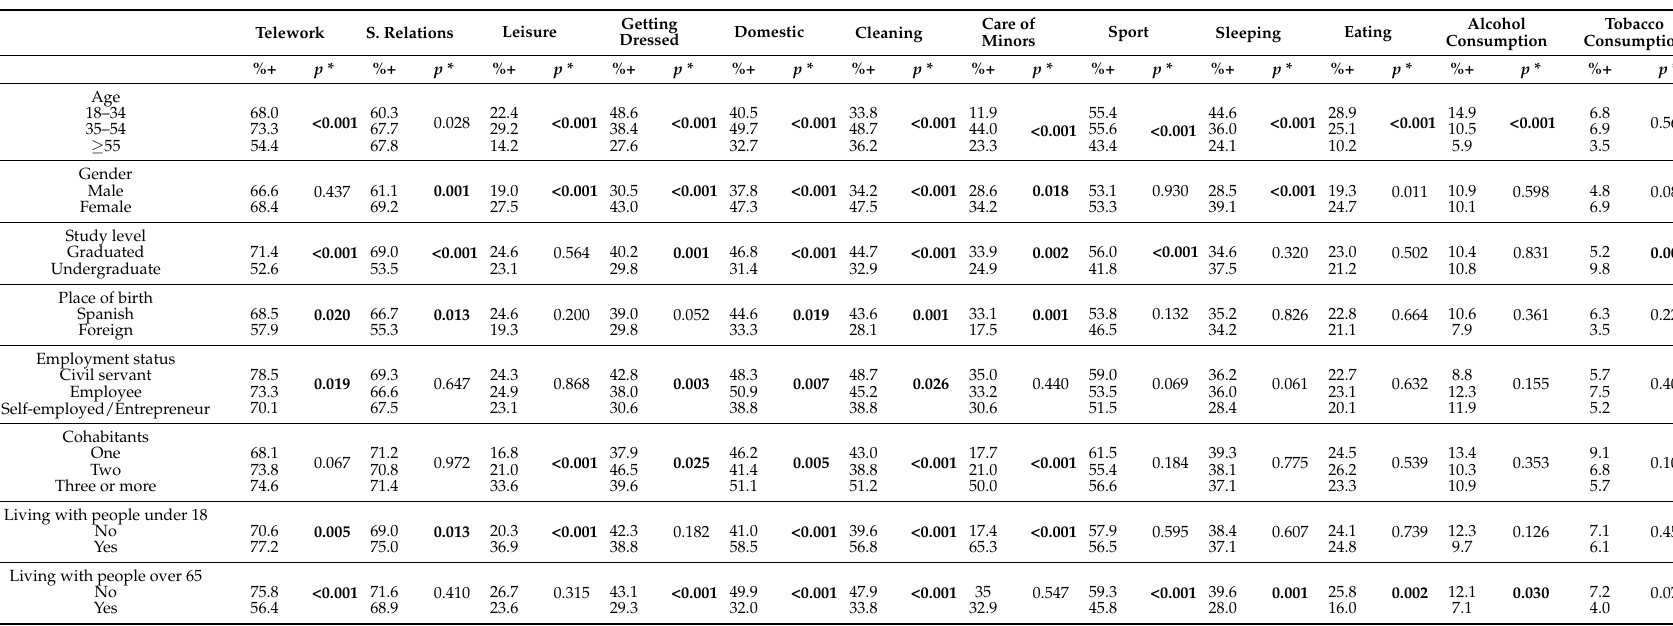
Table 4. Perceived habit changes during confinement according to the different tasks, related to socio-demographic and coexistence characteristics. Telework S. Relations Leisure Getting Dressed Domestic Care of Minors Sport Sleeping